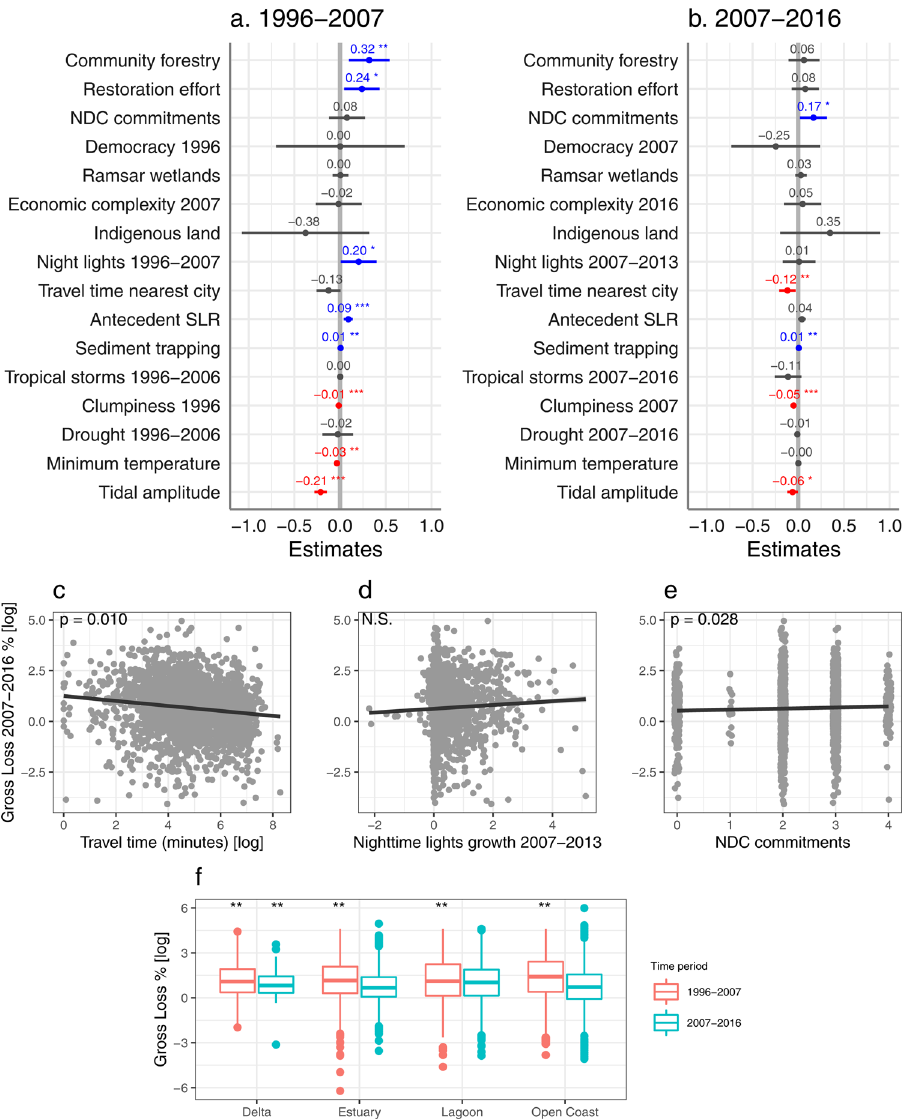
Fig.5|Globaldriversofmangrovegrossloss. Fixedeffectsofsocioeconomicand biophysicalvariablesonpercentgrosslossofmangrovecoverin1996 – 2007( a ; n = 2425mangrovegeomorphicunitsacross55countries)and 2007 – 2016( b ; n =2637 mangrove geomorphic units across 59 countries) showing the estimate and 95% con fi dence intervals from the mixed-effects models. Positive values (in blue) indi- cate that mangrove loss increased with an increase in the variable, while negative values (in red) indicate mangrove loss decreased with an increase in the variable. NDCNationallyDeterminedContribution.SLRsea-levelrise.,Relationshipbetween percent gross loss 2007 – 2016 and travel time to nearest city ( c ), night-time lights